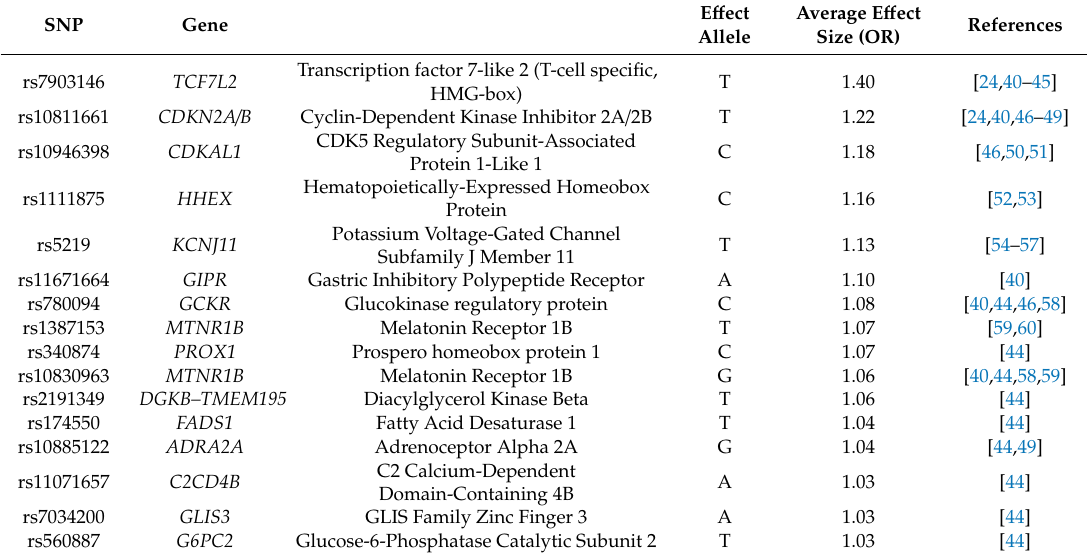
Table 1. List of susceptible single nucleotide polymorphisms (SNPs) considered in the genetic risk score computation with their genes, e ff ect alleles, and average e ff ect size obtained from meta-analyses. SNP Gene